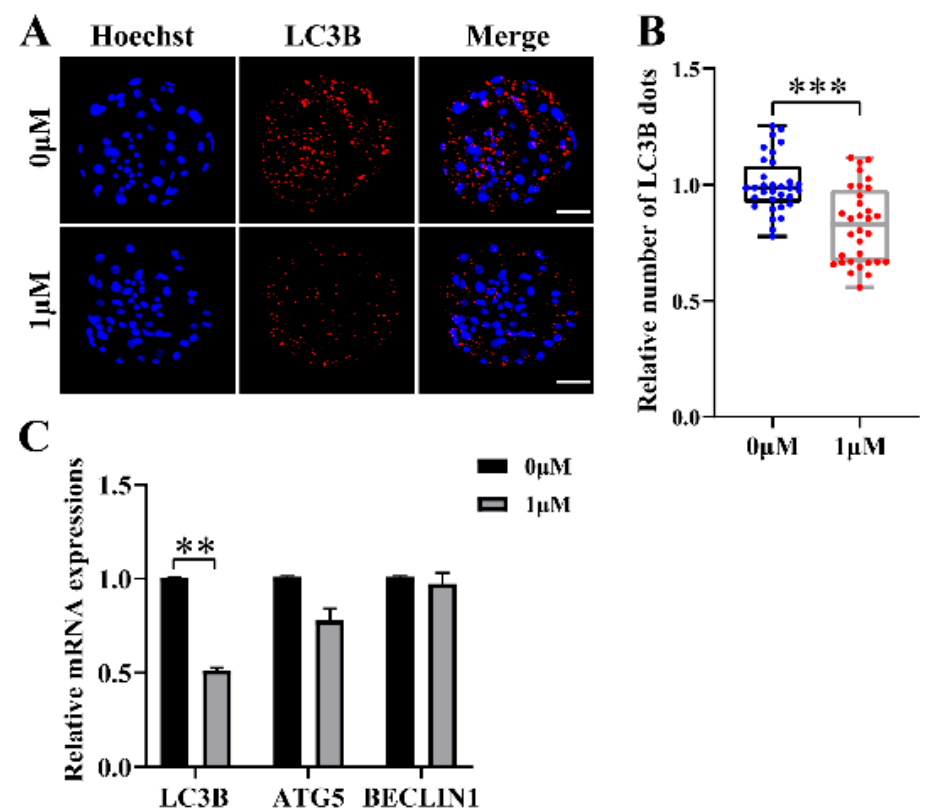
Figure 4. Effect of chrysoeriol (CHE) on the autophagy level of porcine embryos. ( A ) Hoechst and LC3B staining on day 7 in blastocysts. Scale bar = 50 µM. ( B ) Number of LC3B dots in the control (0 µM) (n = 32) and the CHE treatment (1 µM) (n = 32). R = 4. Data represent medians and maxima and minima. Significant differences are shown as *** ( p < 0.001). ( C ) Changes in gene expression levels related to autophagy after the addition of CHE. Significant differences are shown as ** ( p < 0.01).